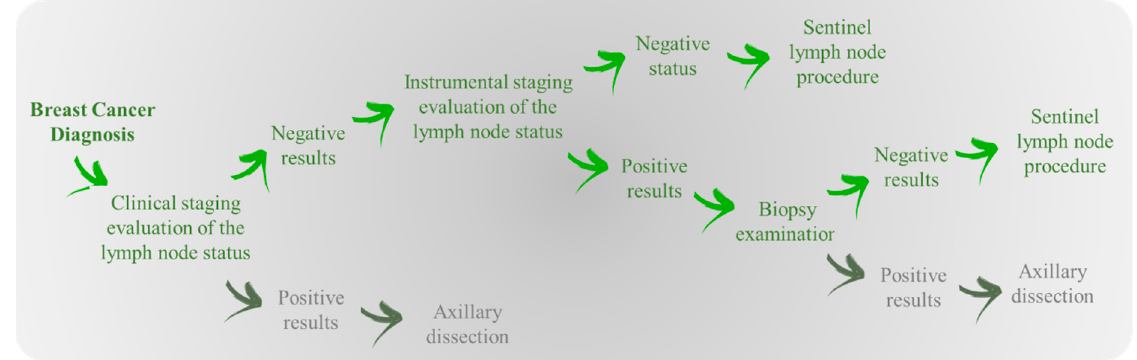
Figure 1. The diagram shows the typical processes of the work-up and interventions used in practice for breast cancer patients with clinically negative lymph nodes.